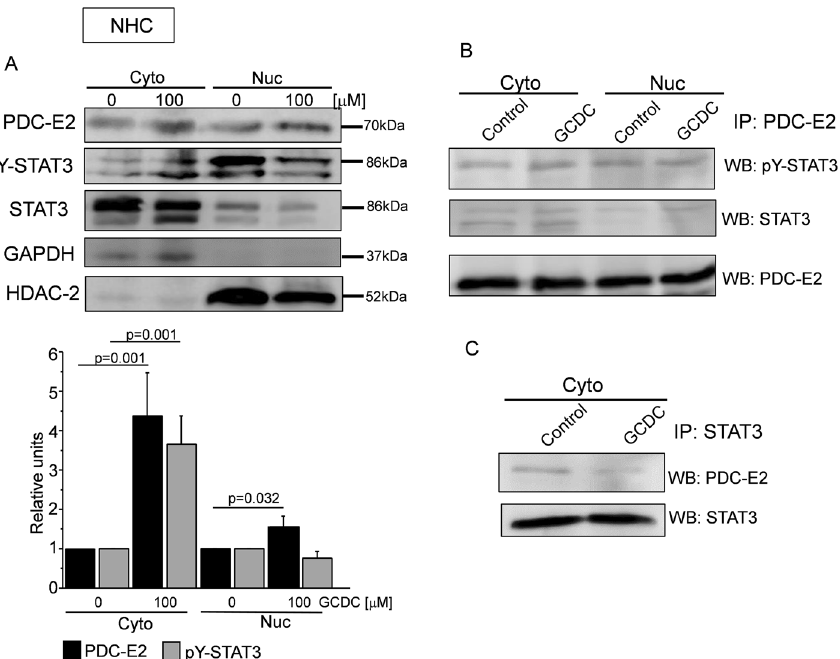
Figure 1. PDC-E2 associates with p-STAT3 and STAT3 in unstimulated and GCDC-stimulated cholangiocytes. Normal human cholangiocytes (NHC) stimulated with 100 µM of glycochenodeoksycholic acid (GCDC) were collected and subjected to subcellular fractionation in order to obtain cytoplasmic (Cyto) and nuclear (Nuc) fractions. ( A ) PDC-E2, pY-STAT3 and STAT3 were detected by using appropriate antibodies and normalized to GAPDH (cytoplasmic fraction) or HDAC-2 (nuclear fraction). Level of each protein was presented as a mean ± SEM. ( B and C ) Immunoprecipitation (IP) utilized anti-PDC-E2 or anti-STAT3 antibody and